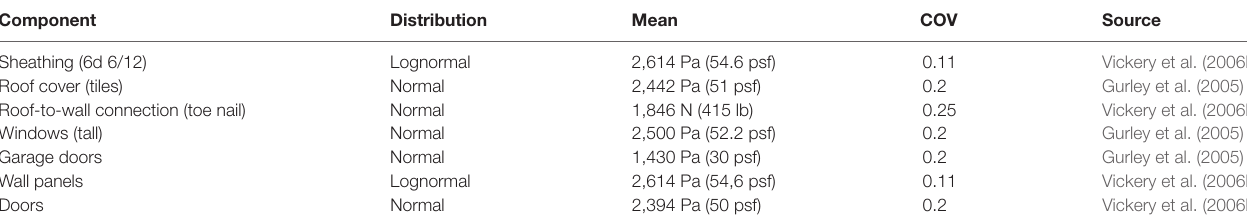
TaBle 1 | Capacity of house components: built before